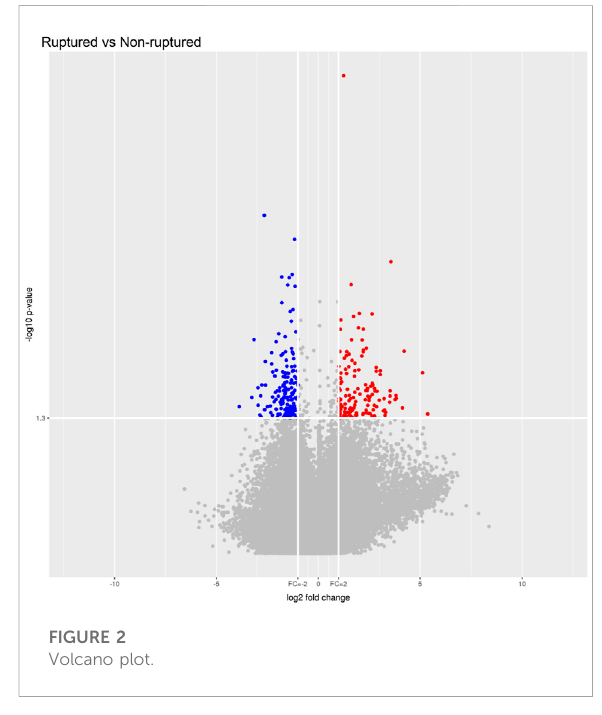
FIGURE 2 Volcano